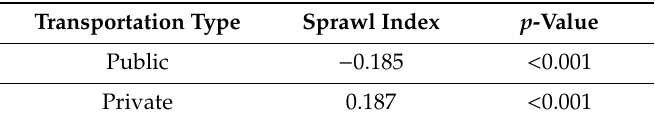
Table 3. Correlation between urban sprawl and transportation type.